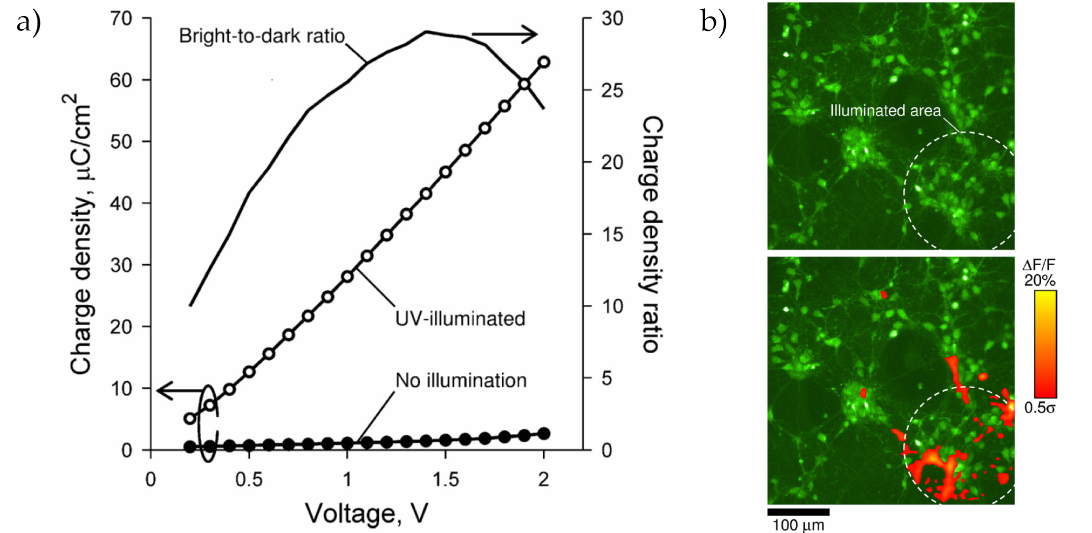
Figure 5. ( a ) Example of the charge density for a porous titanium dioxide light-addressable electrode with different, applied voltages under and without illumination. ( b ) Ca 2 + fluorescence image of rear-side illuminated spatial stimulation of Wistar rat embryo neurons cultivated on titanium dioxide: Neurons show fluorescence changes at the illuminated areas. Reprinted from Reference [73] Copyright (2020), with permission from